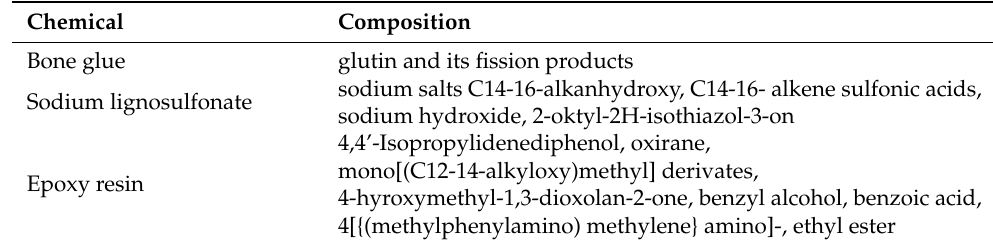
Table 1. Chemical composition of used materials.